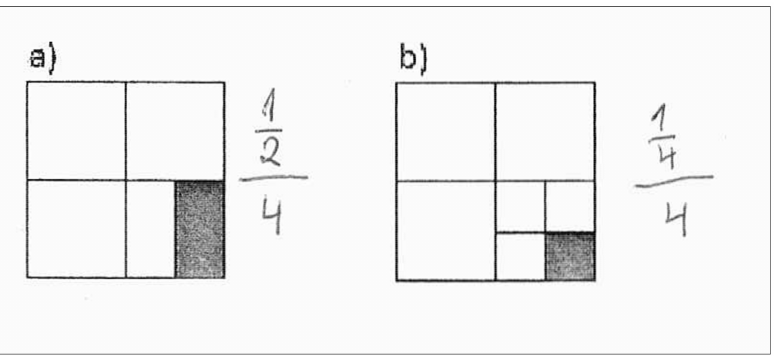
Figure 11. Procedural knowledge of